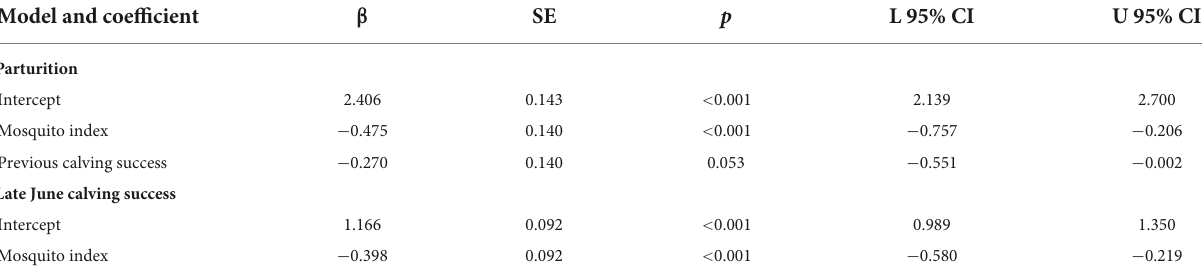
TABLE 5 Standardized coefficients from the top population-level models of parturition and late June calving success of adult female caribou in the Central Arctic Herd, Alaska,